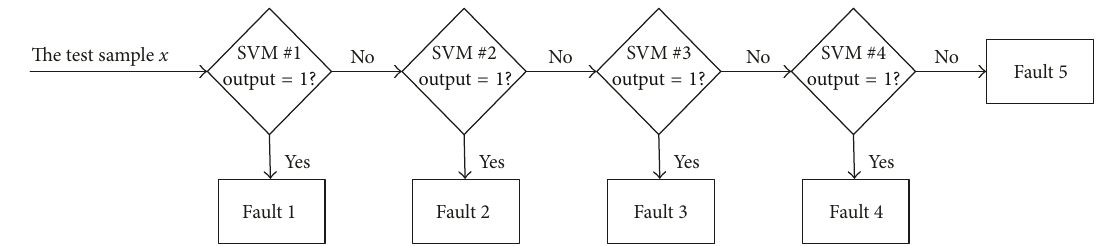
Figure 2: Architecture of the SVM-based fault classification